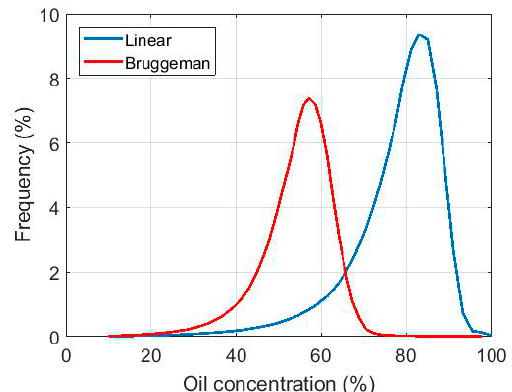
Figure 14. Normalized histograms of oil concentration estimated within the mineral oil slick released during the MOS Sweeper exercise (10:02 UTC) using the linear mixing model (blue) and the Bruggeman formula (red).